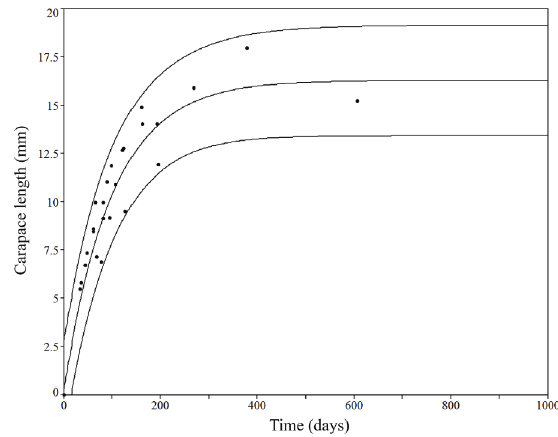
Figure 7 - Rimapenaeus constrictus . Mean estimated growth curve based on the von Bertalanffy growth model for males sampled from July 1998 to June 2003 in the Ubatuba region, northern São Paulo state. Outer lines: 95% prediction